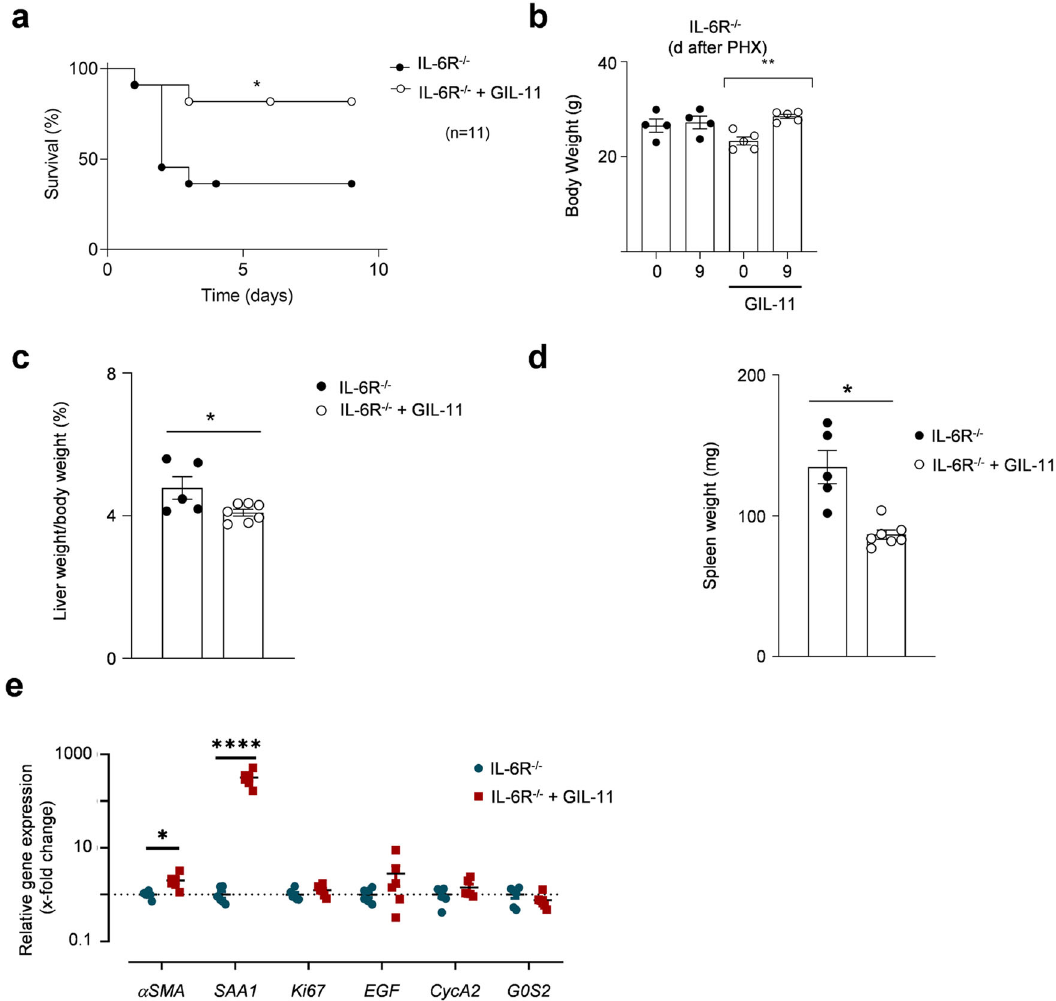
Fig. 7 Human GIL-11 rescued IL-6R − / − mice from death following partial hepatectomy. a IL-6R − / − mice were subjected to 70% PHX, injected with PBS ( n = 11) or GIL-11 ( n = 11), 20 µ g each, 24 h before and directly after surgery and survival was monitored for 9 days. b Body weight of IL-6R − / − mice treated with and without GIL-11 after 70% PHX was determined 12 days after PHX ( n = 4 untreated, n = 5 GIL-11). c Liver/body weight ratio of IL-6R − / − mice treated with and without GIL-11 after 70% PHX was determined at 9 days after PHX ( n = 5 untreated, n = 7 GIL-11). d Spleen weight of IL-6R − / − mice treated with and without GIL-11 after 70% PHX was determined at 9 days after PHX ( n = 5 untreated, n = 7 GIL-11). e Total RNA was extracted from the liver directly after PHX from IL-6R − / − mice previously treated with and without GIL-11 and mRNA level of aSMA, SAA1, Ki67 , EGF, CycA2 and G0S2 were determined by quantitative PCR ( n = 6). b – e Each dot represent data derived from one mouse. Error bars are